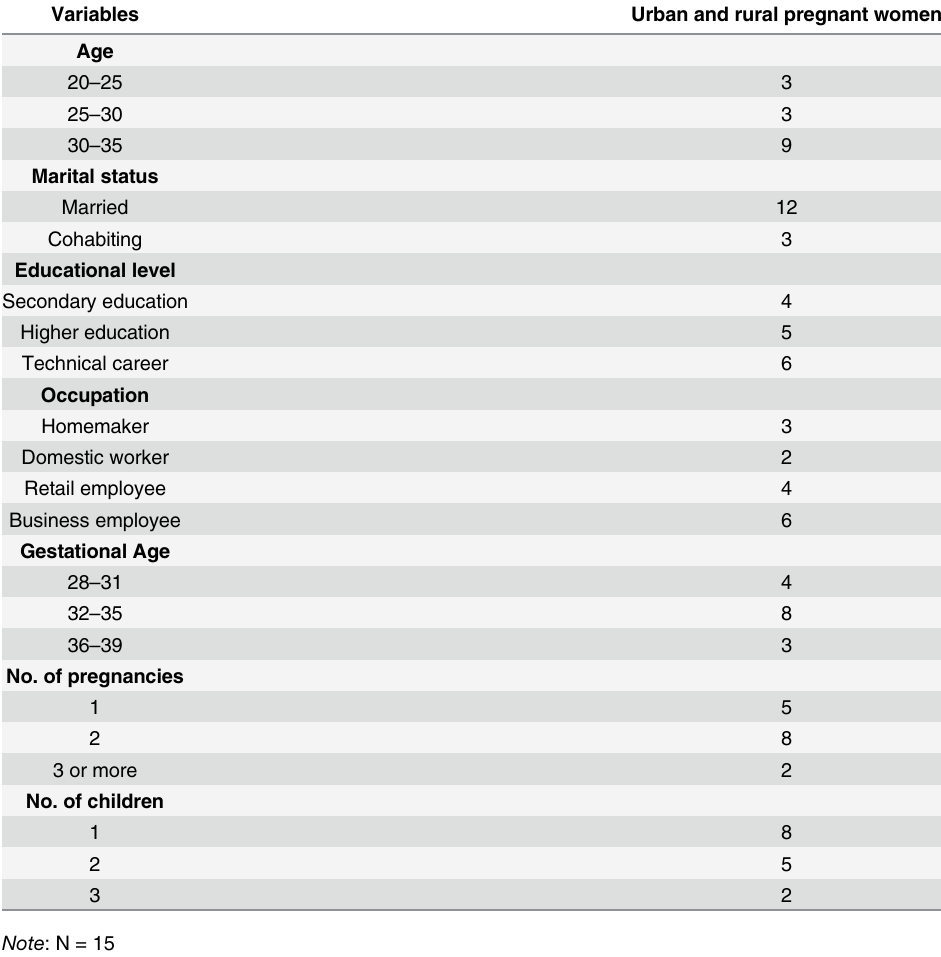
Table 2. Socio-demographic characteristics of the sample: urban and rural pregnant